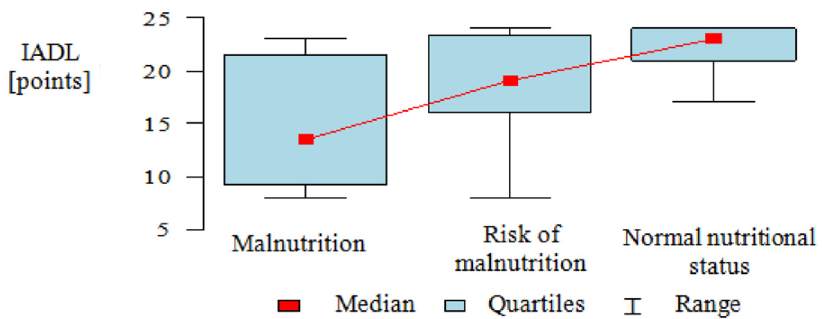
Figure 2. Ability to perform instrumental activities of daily living by nutritional status.